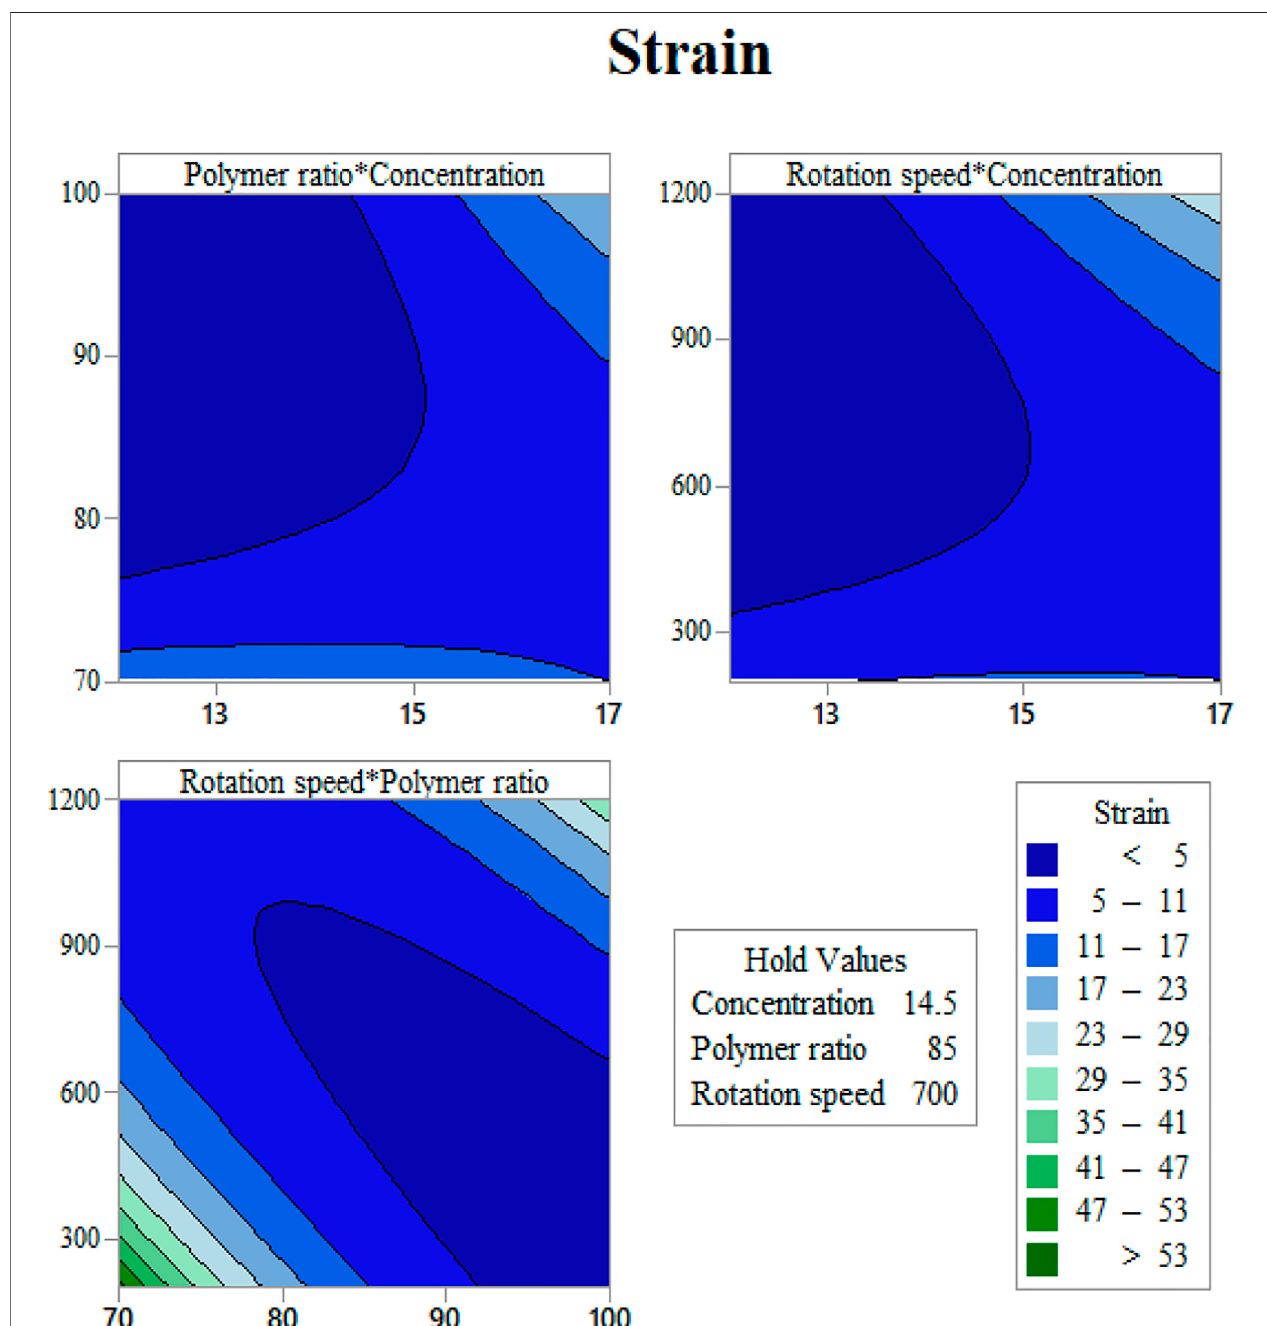
FIGURE 5| Strain at rupture contours asfunctions of inputvariables: (A) gelation content vs. concentration, (B) mandrel rotation speed vs. concentration, and (C) mandrel rotation speed vs gelatin content.